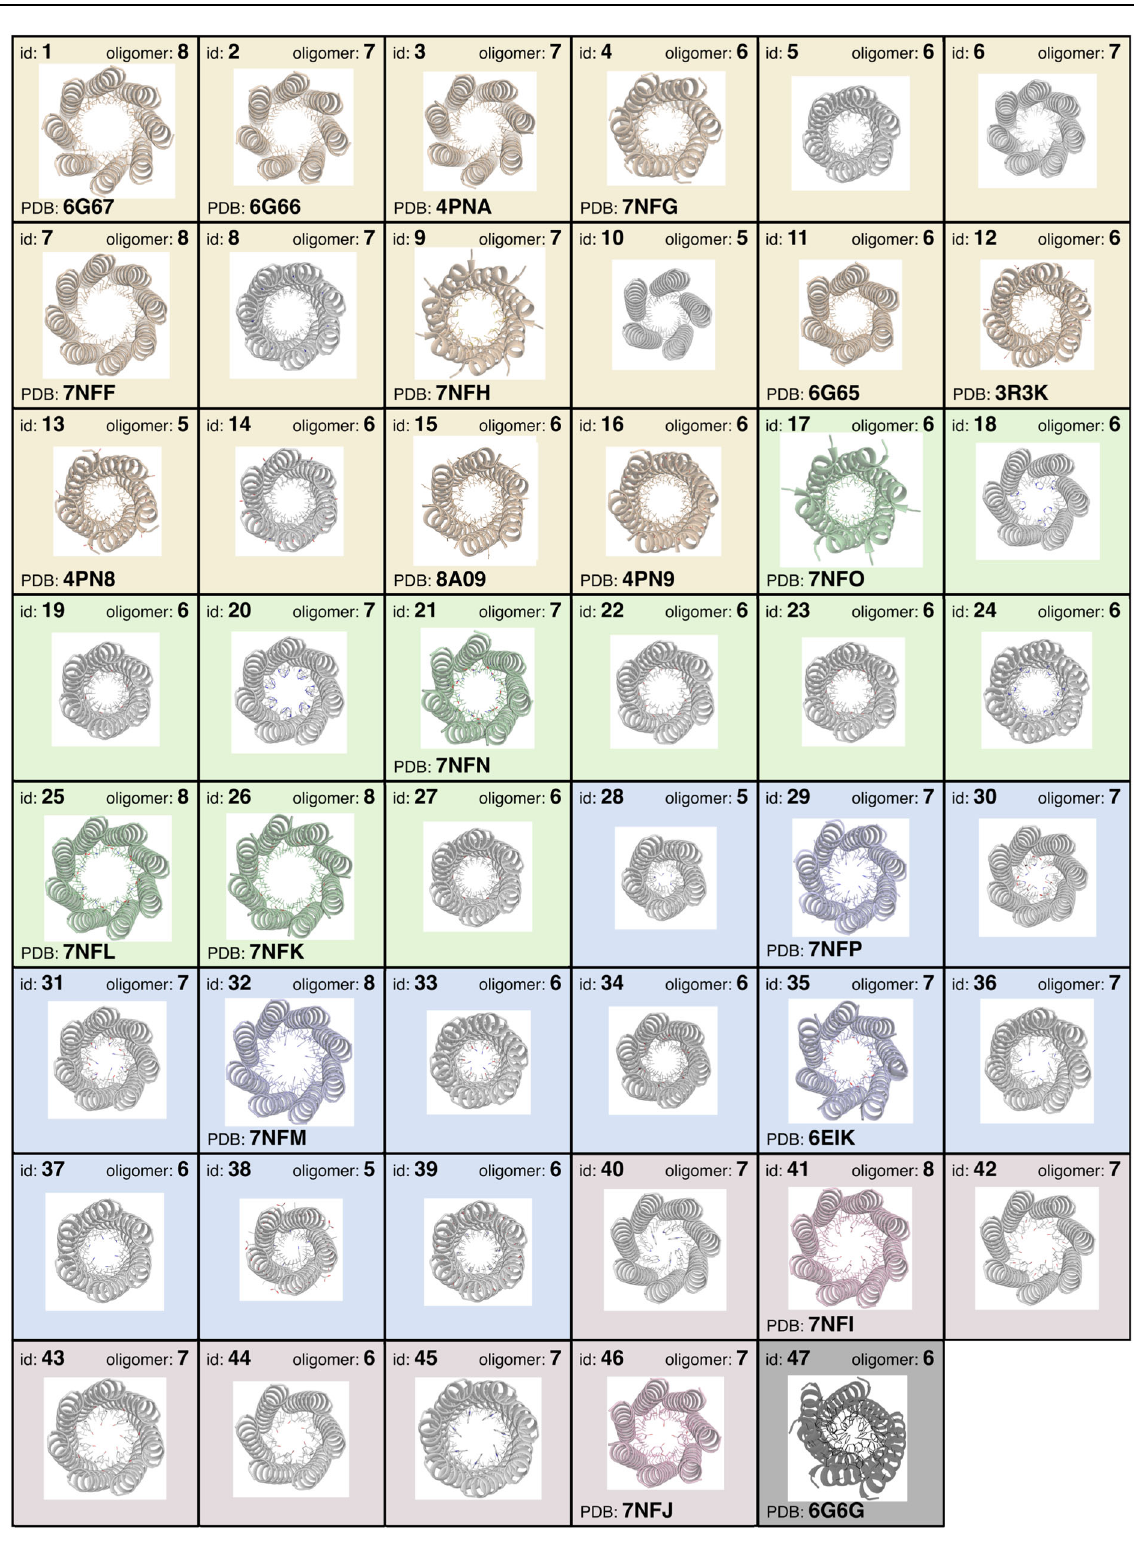
(Fig. 2 and Supplementary Data File 1): Group I had entirely hydro- phobic interiors, but with different sizes and shapes of channel; Groups II and III had polar uncharged or polar charged residues, respectively, at speci fi c points along the channel; and Group IV had aromatic residues installed in their